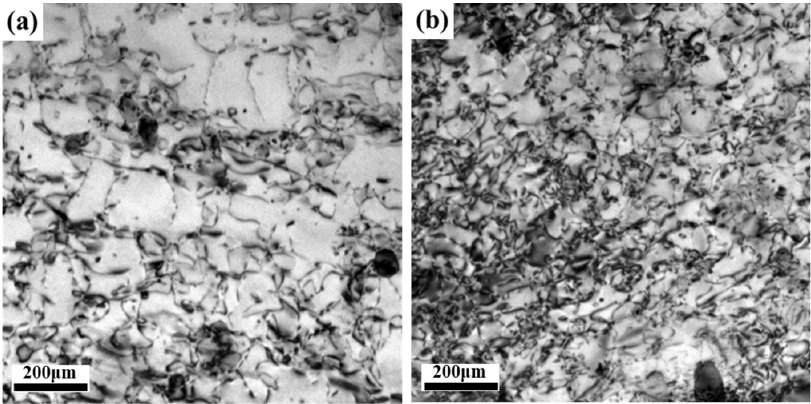
Figure 10. Dislocation morphology images of the Cl specimen of TDSP tensioned to a fixed strain of 0.12 at ( a ) 25 °C and ( b ) − 196